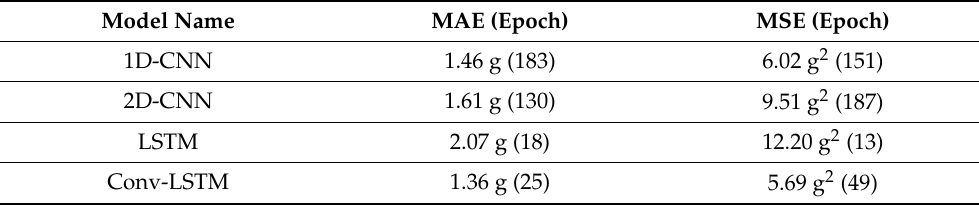
Table 3. Best performances of deep learning models (in terms of MAE and MSE).